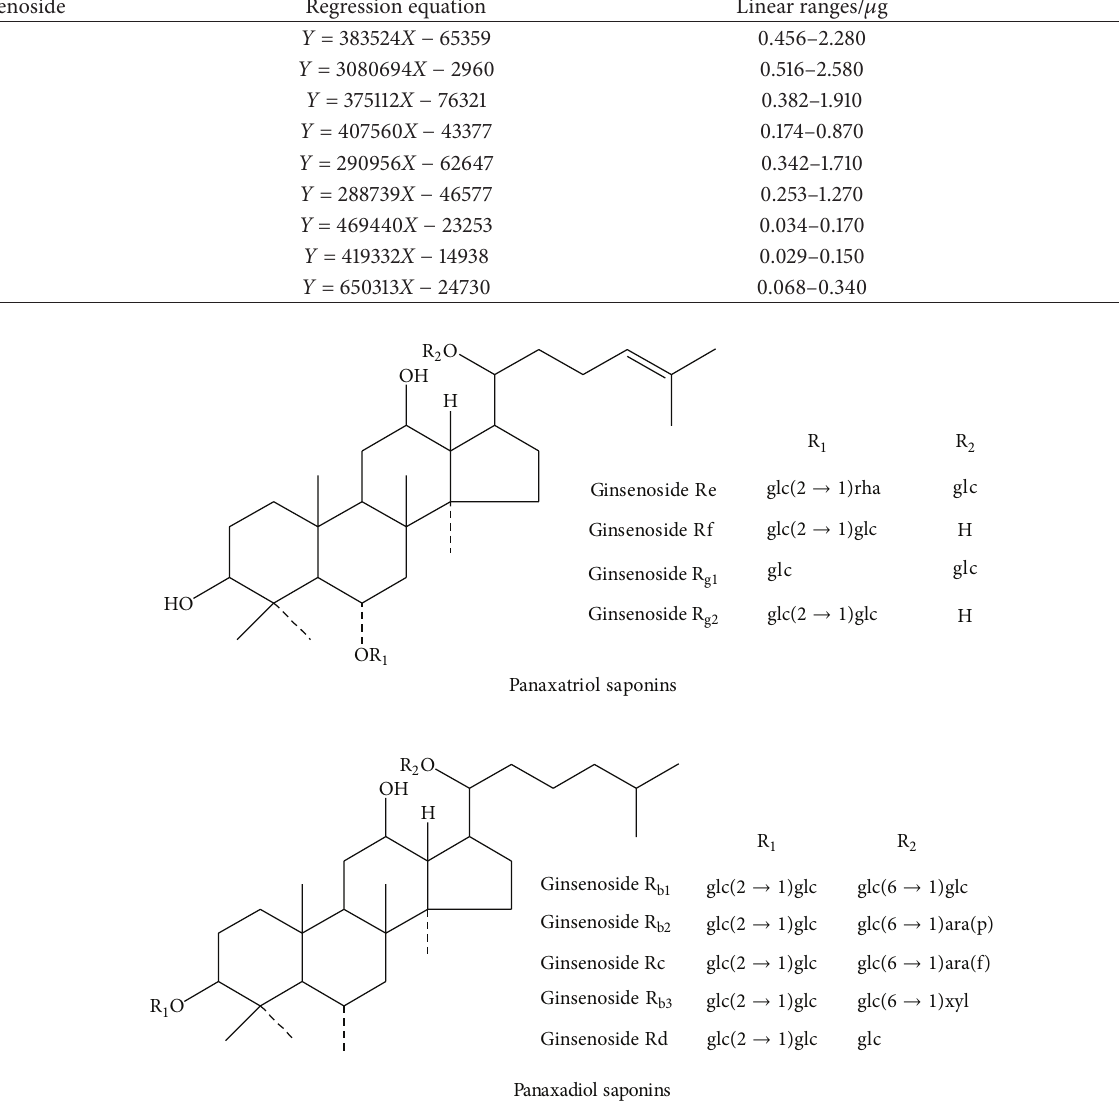
Figure 1: Chemical structures of the nine ginsenosides.